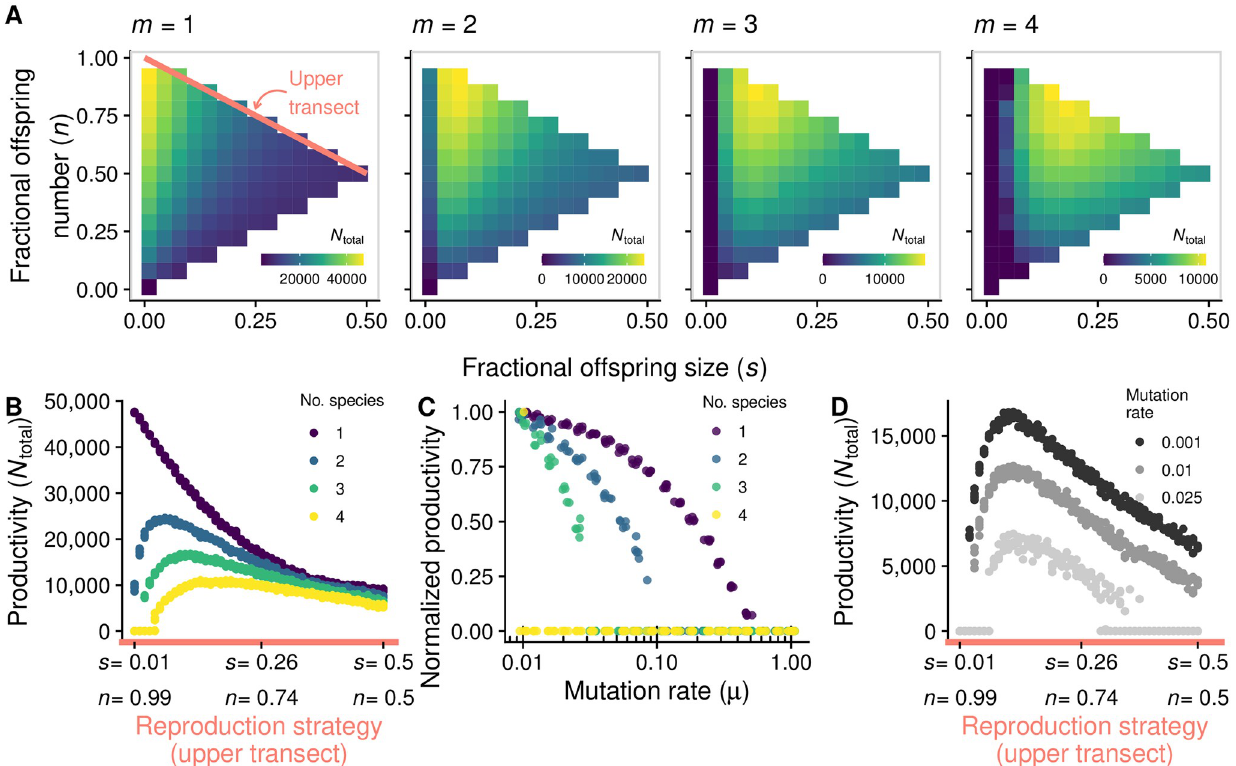
Fig 4. When community complexity is high, the productivity peak shifts away from unicellular bottlenecks. A : The color indicates equilibrium community productivity ( N total ). As the number of species ( m ) increases, the strategy that maximizes N total moves rightward along the upper transect (pink line) of the strategy space. B : Equilibrium productivity as a function of strategies along the upper transect of the strategy space (corresponding to the pink line from panel A ; ranges from complete fragmentation, on the left of the x axis, to binary fission, on the right), for different numbers of species. C : Equilibrium productivity decreases with mutation rate ( μ ); this decrease is faster for higher number of species (exemplified here for s = 0.1, n = 0.9.). The plot depicts the productivity at equilibrium relative to the case in which μ is very small ( μ = 0.01). D : Some strategies that do well with small μ (large offspring) are not viable when μ is large (shown here with m = 3). Parameters: all parameters are set to the default values, unless otherwise indicated (Table A in S1